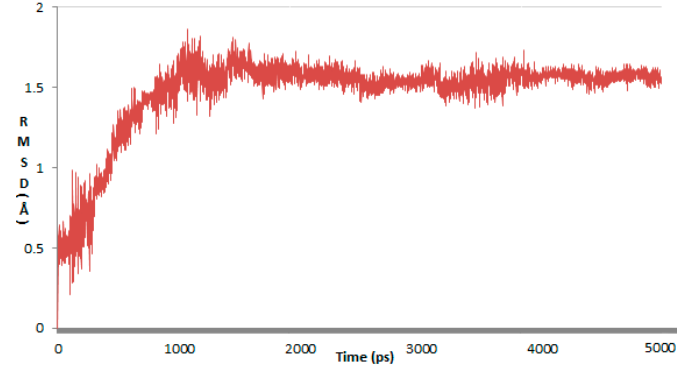
Figure 9. Root mean square deviation (RMSD) confirmations of protein-ligand complexes between 1 and 5 ns.